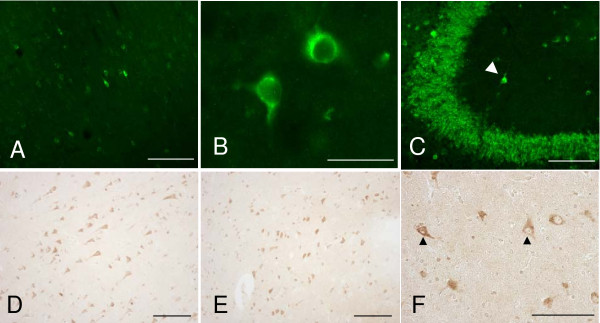
Analysis of HMIT expression in rat and human brain. Fluorescence microphotographs of adult male rat coronal sections immunolabelled with anti-HMIT antibody. HMIT-LI distribution in the secondary motor cortex (M2), at approximately +1.20 mm from Bregma at low (A) and high magnification (B); and in the CA3 hippocampal region, approximately -2.80 mm from Bregma (C); the arrowhead indicates a HMIT-positive interneuron; Scale bar = 100 μm (A, C) and 50 μm (B). Microphotographs of formalin-fixed paraffin embedded sections of human brain areas immunolabelled with anti-HMIT antibody. HMIT staining is visible in cell bodies and projections of different regions of the human brain: cerebral cortex (D); hippocampus (E) and thalamus (F), the latter at higher magnification, in which two examples of HMIT positive staining are indicated by the arrowheads. Scale bar = 50 μm (D, E, F).